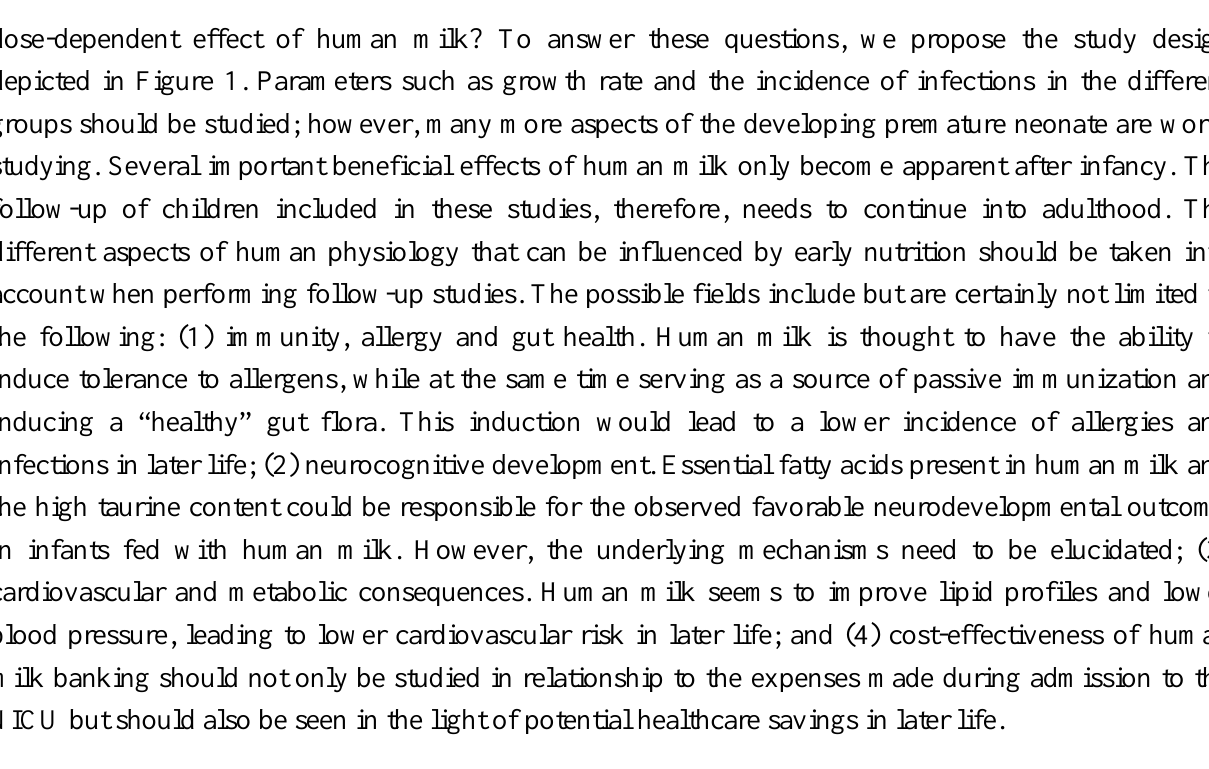
Figure 1. Study design. (Group IA and IB will only be supplemented with donor milk or formula, respectively, if their own mother’s milk supply is